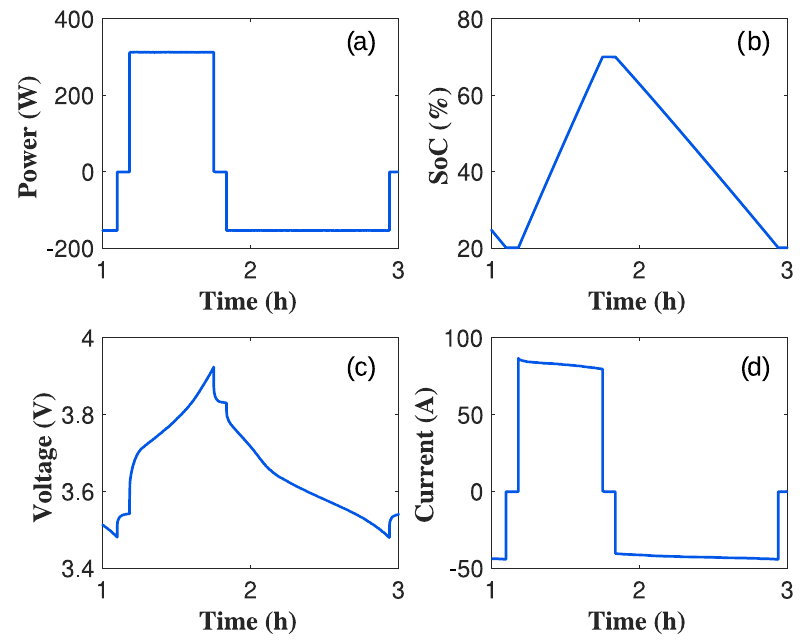
Figure 14. ( a ) Power, ( b ) state of charge, ( c ) voltage and ( d ) current evolution during a mobile charging station usage